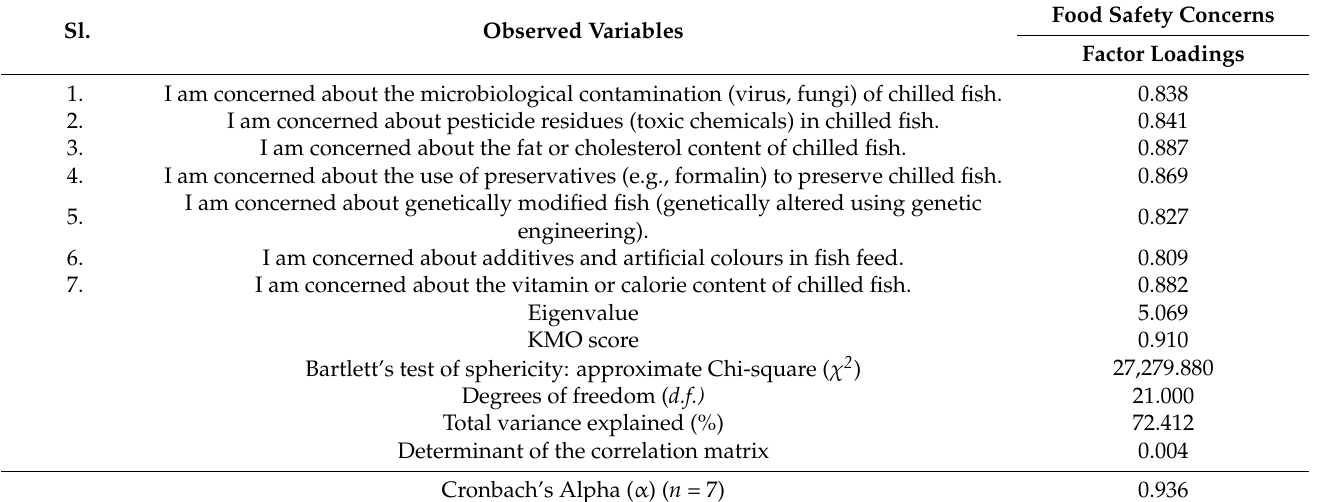
Table 3. Exploratory factor analysis outcome.